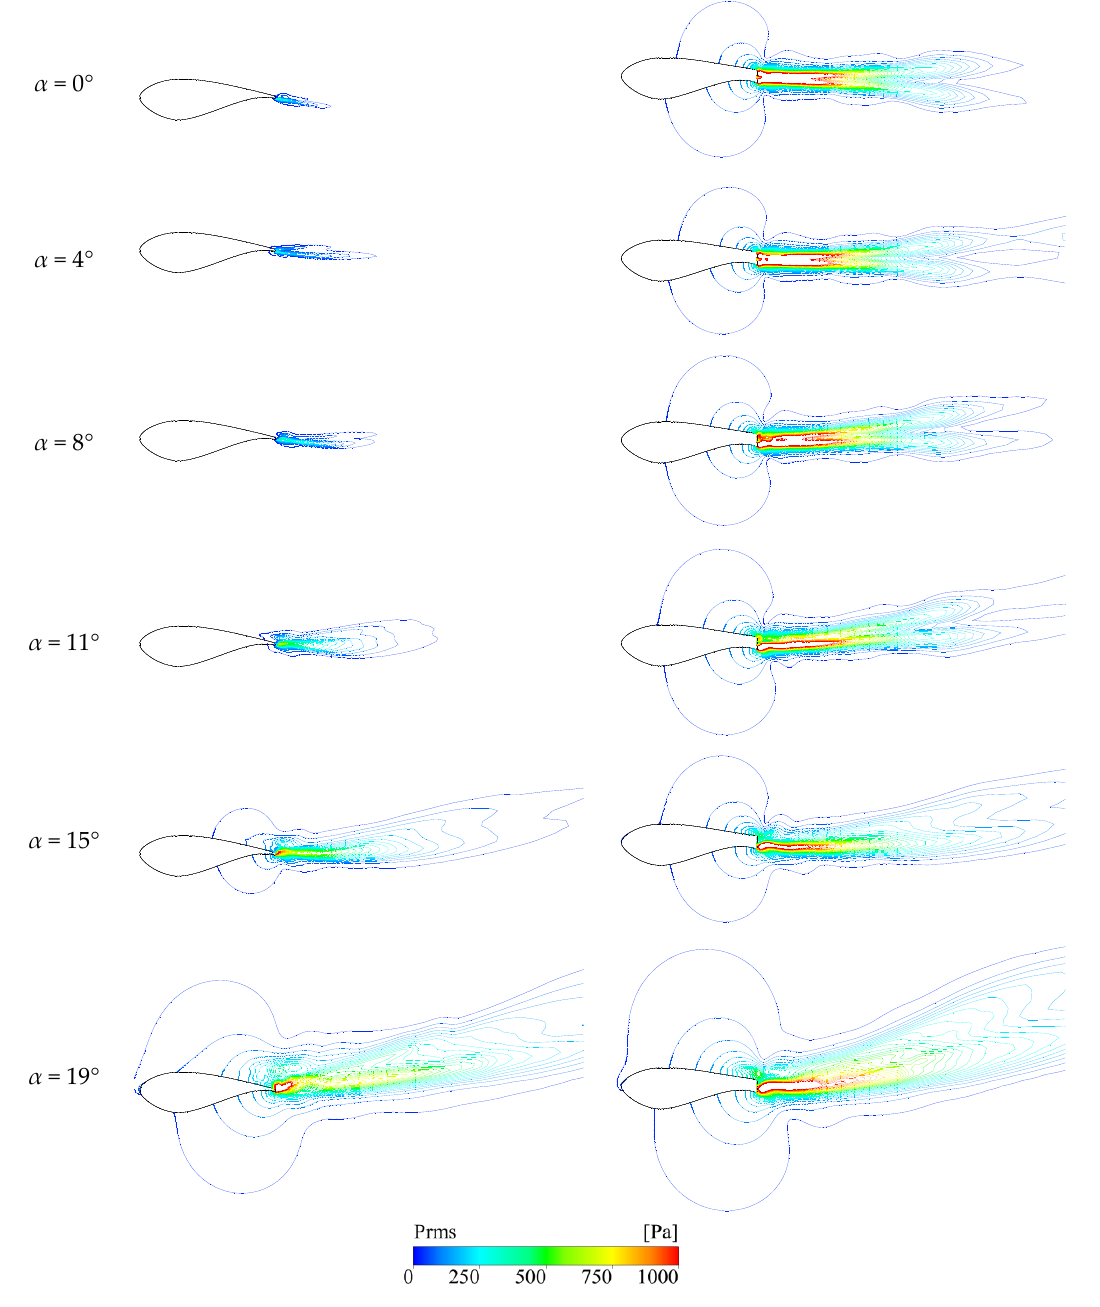
Figure 19. Contours of P rms .